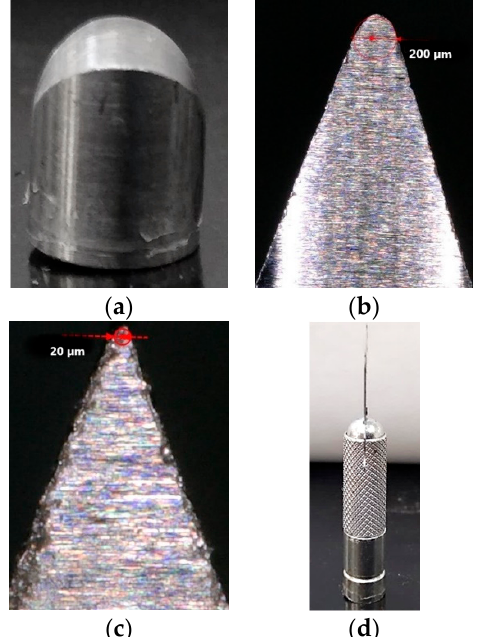
Figure 2. Indenter geometries ( a ) Round projectile (radius of curvature: ROC = 3.8 mm), ( b ) 200-micron indenter, ( c ) 20-micron indenter and ( d ) Razor blade (ROC ~ 2 micron).